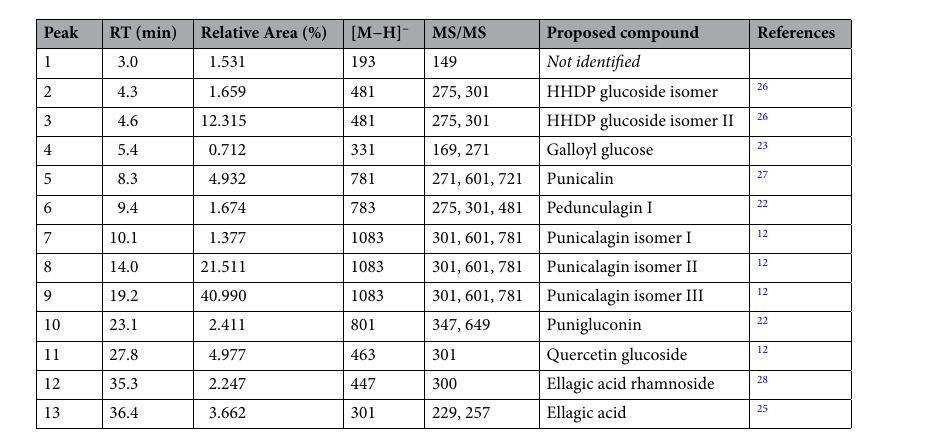
Table 3. Identified compounds in the GP extract using HPLC–MS.